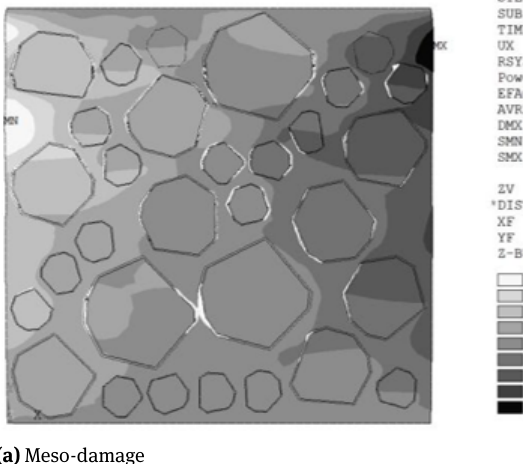
Figure 5: Macro-meso damage contrast chart